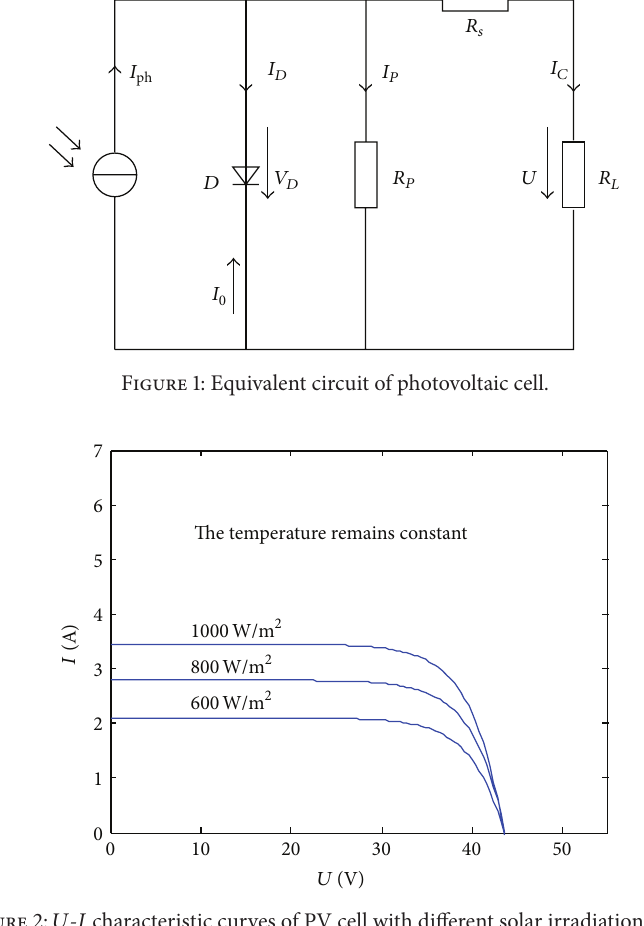
Figure 2: 𝑈 - 𝐼 characteristic curves of PV cell with different solar irradiation